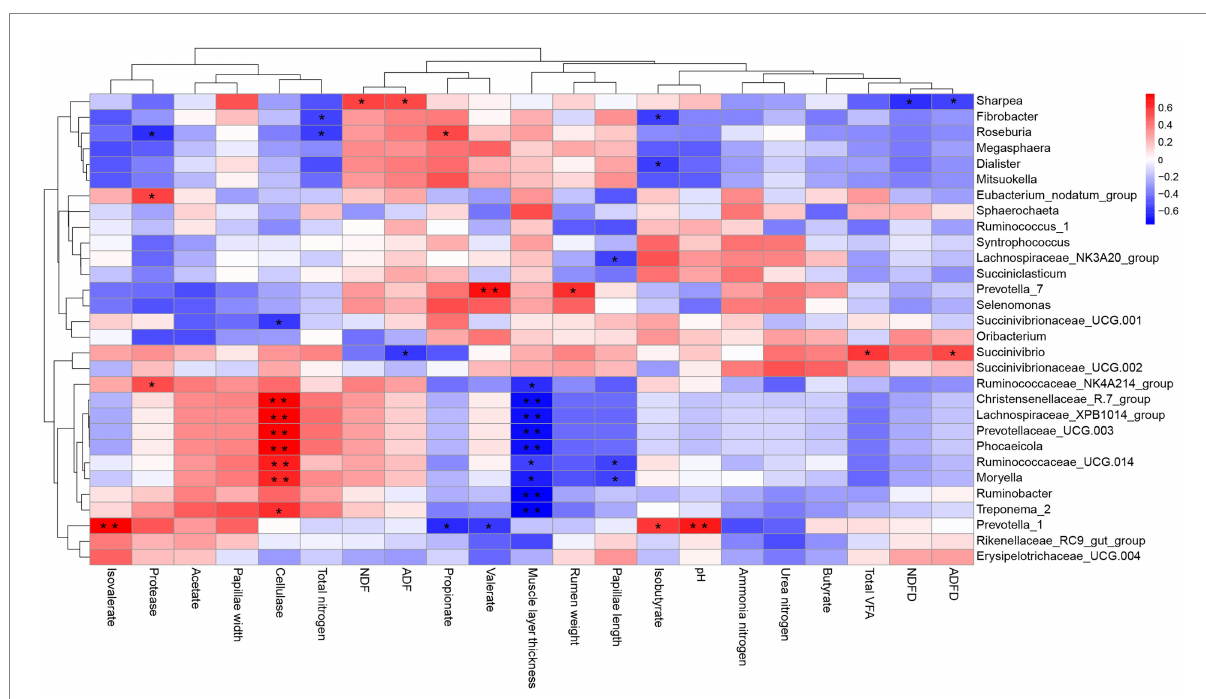
FIGURE 5 Correlation between the top 30 genus-level taxonomic compositions and rumen weight, pH, fermentation parameters, and enzyme activity. * p < 0.05, ** p <